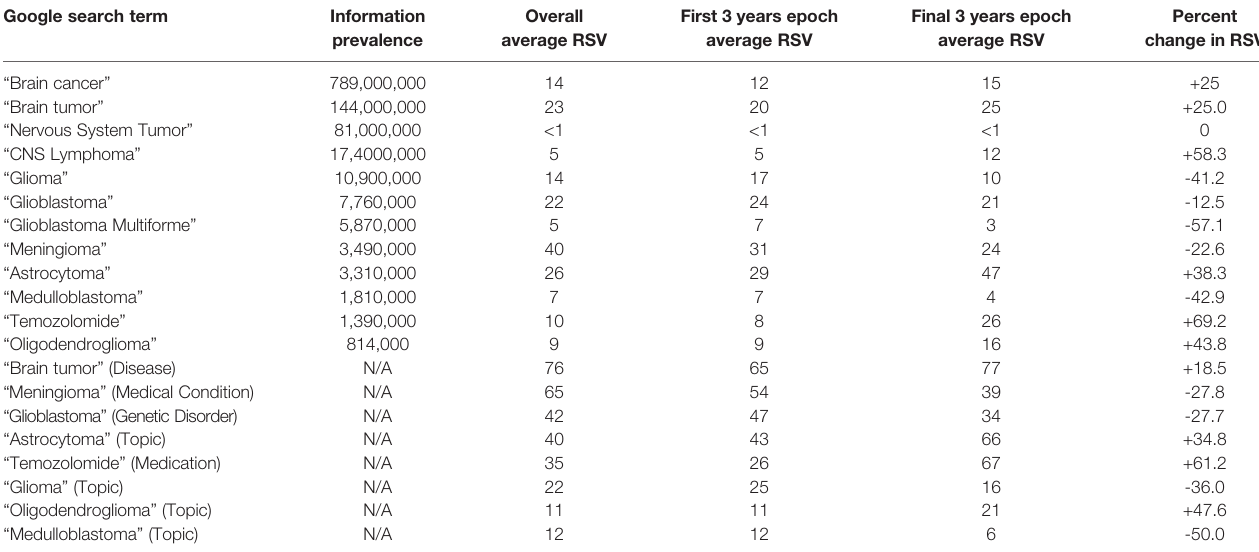
TABLE 1 | Average relative search volume (RSV) and information prevalence from Google search and